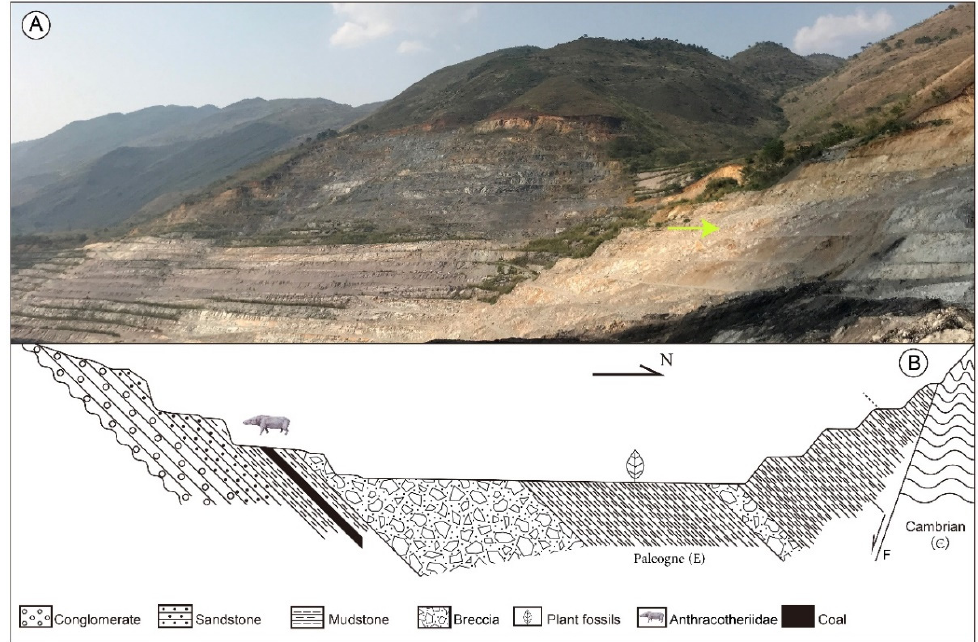
Figure 3. Cross section of the fossil locality in Puyang Basin, southeastern Yunnan Province, China. ( A ) The fossiliferous outcrop. The light green arrow indicates the layers where our fossils were collected. ( B ) Cross section of the fossil locality.